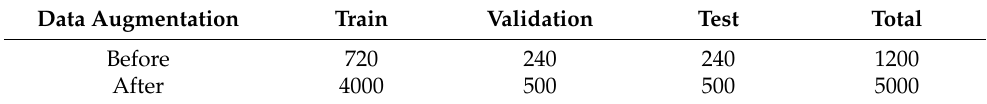
Table 2. The experimental